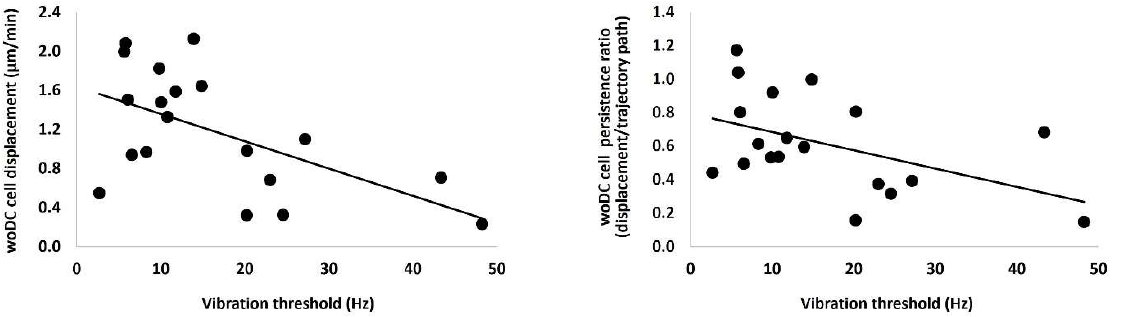
Figure 4. Relationship between corneal immune cell parameters and neuropathic measures in type 1 diabetes. woDCs; dendritic cells without visible dendrites. diabetes. woDCs; dendritic cells without visible